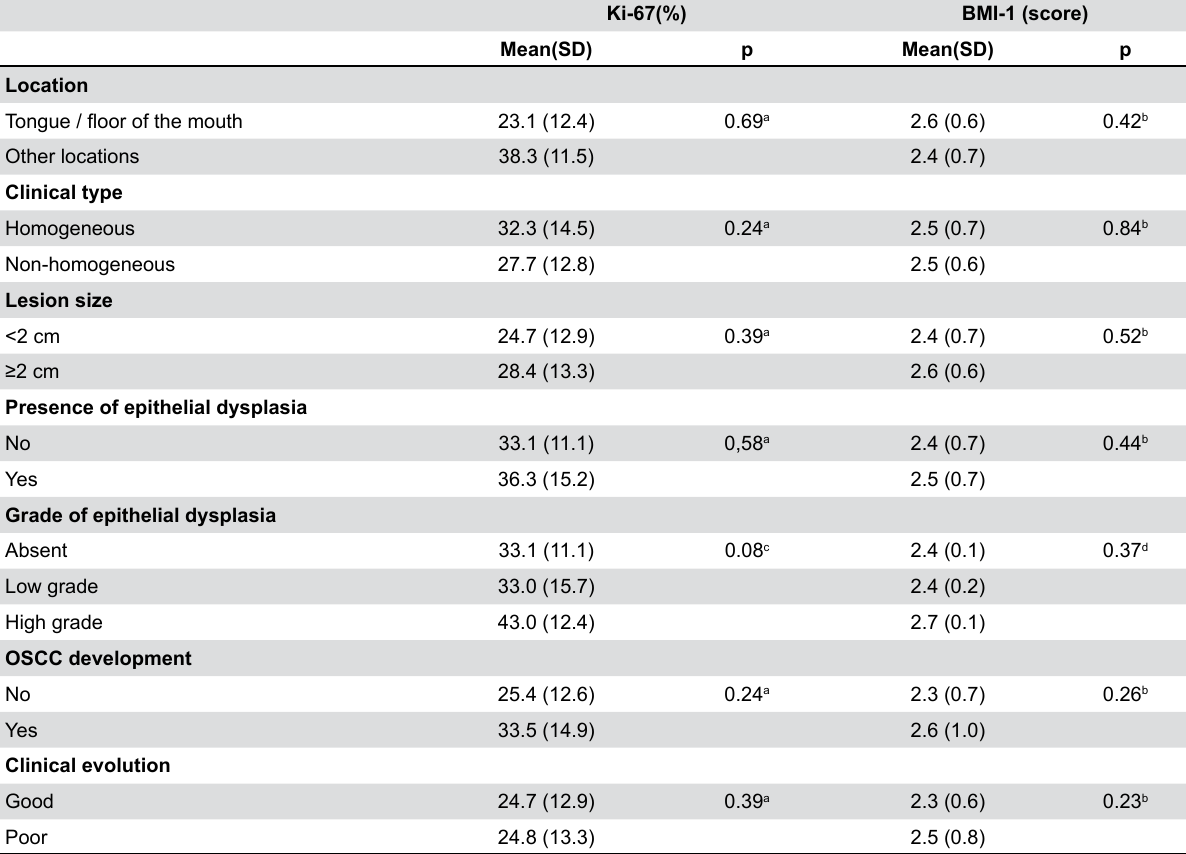
KLEIN IP, MEURER L, DANILEVICZ CK, SQUARIZE CH, MARTINS MD, CARRARD Table 4- Clinical and histopathological characteristics in OL cases and the association with the expression of Ki-67 and BMI-1